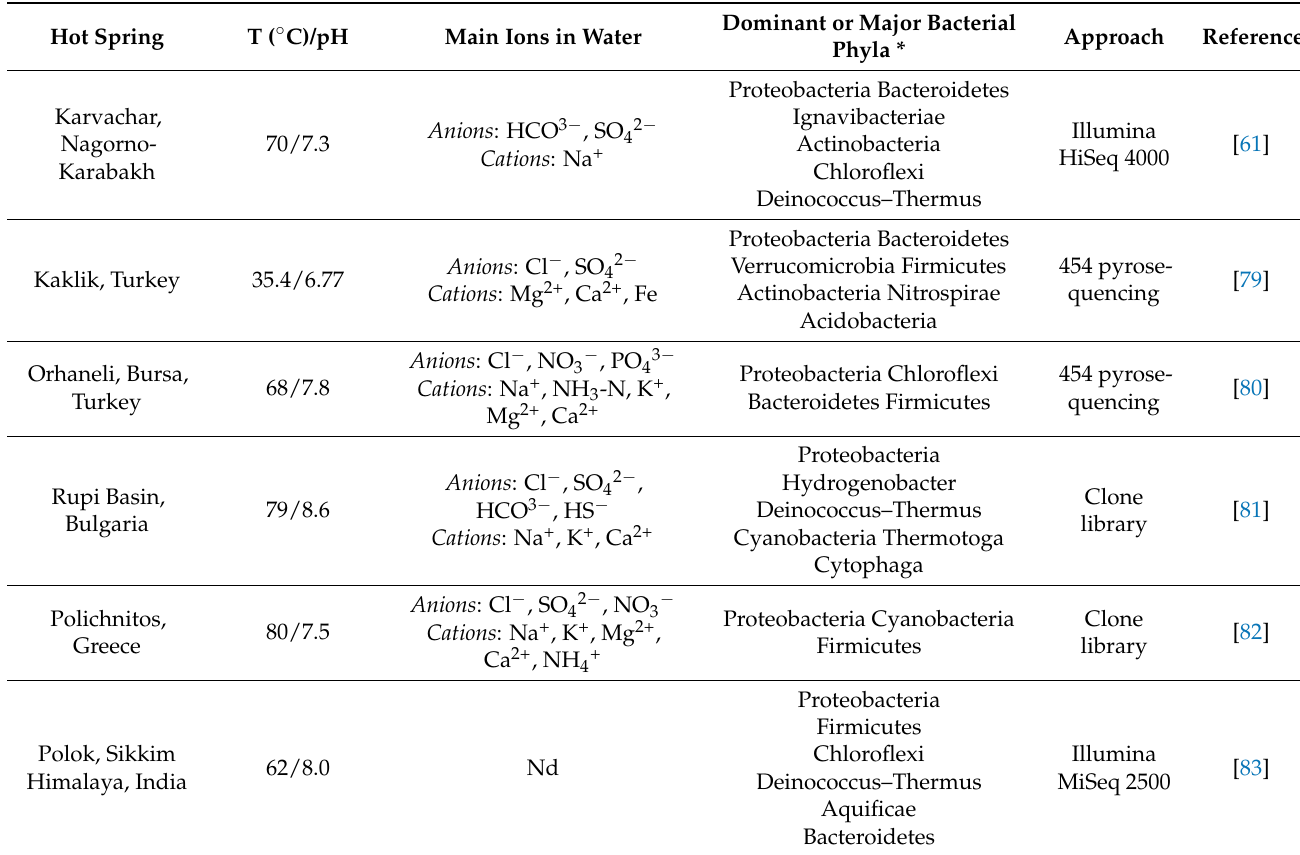
Table 5. Comparison of bacterial diversity in different terrestrial hot